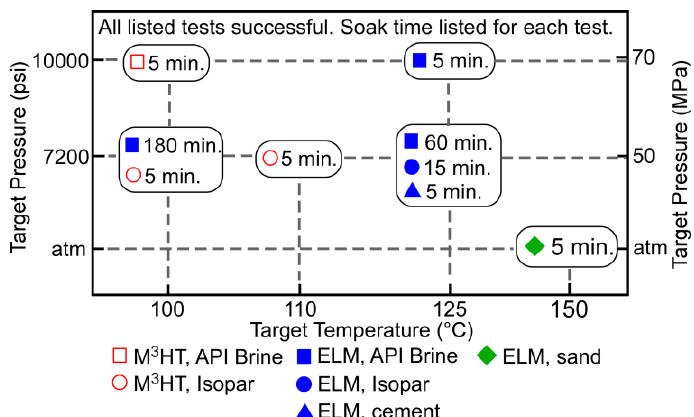
Figure 6. Summary of HPHT test results. All tests listed in the figure were successful. The soak time for each test is shown. The total time for each test included the soak time, ≈30 min ramp up, and ≈30 min ramp down.